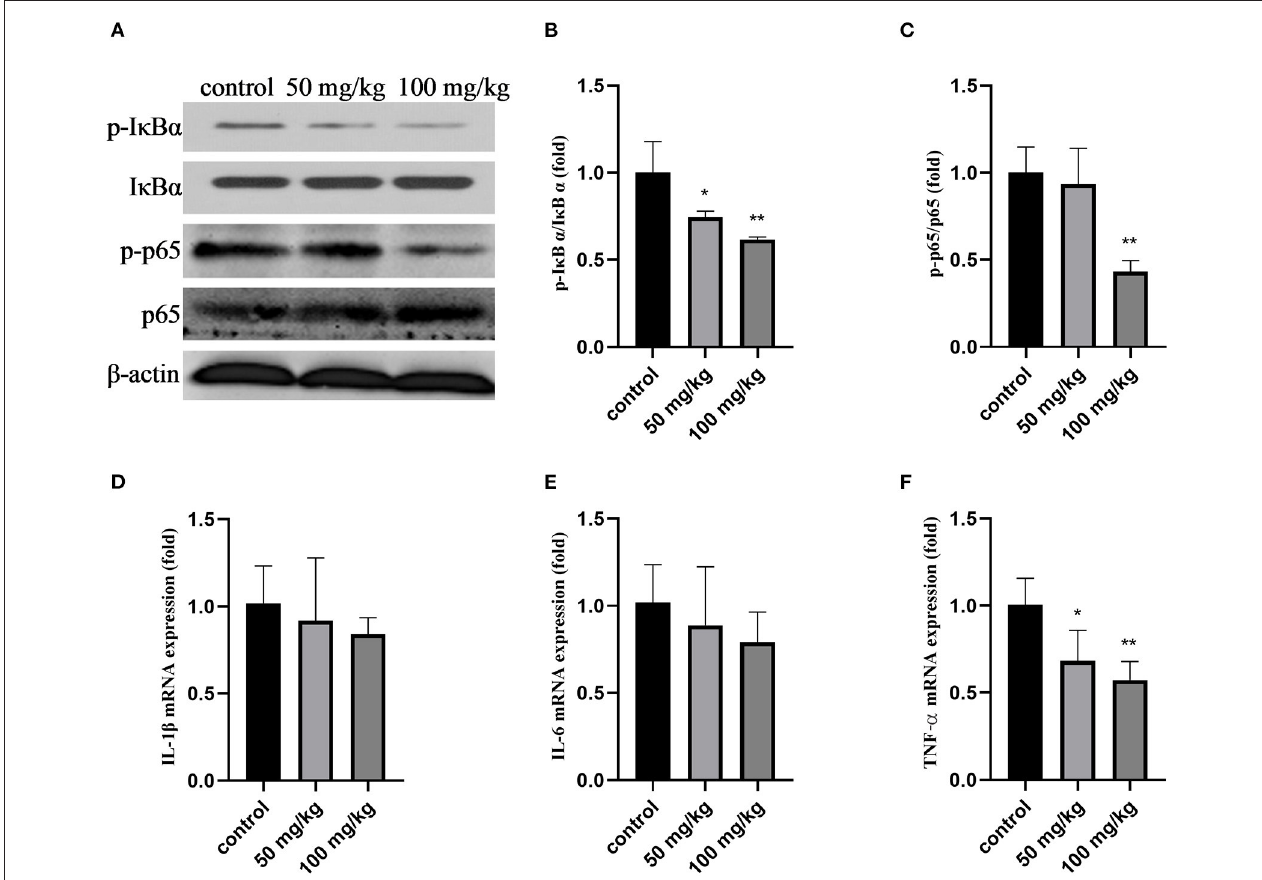
FIGURE 1 | Effects of rutin supplementation on inflammation of mammary gland in sheep during the transition. (A) Western blot analysis of p-I κ B α , I κ B α , p-p65, and p65. (B) Ratio of p-I κ B α /I κ B α . (C) Ratio of p-p65/p65. (D–F) Relative mRNA abundance of IL-1 β , IL-6 and TNF- α . Data are presented as means ± SE. * P < 0.05, ** P <